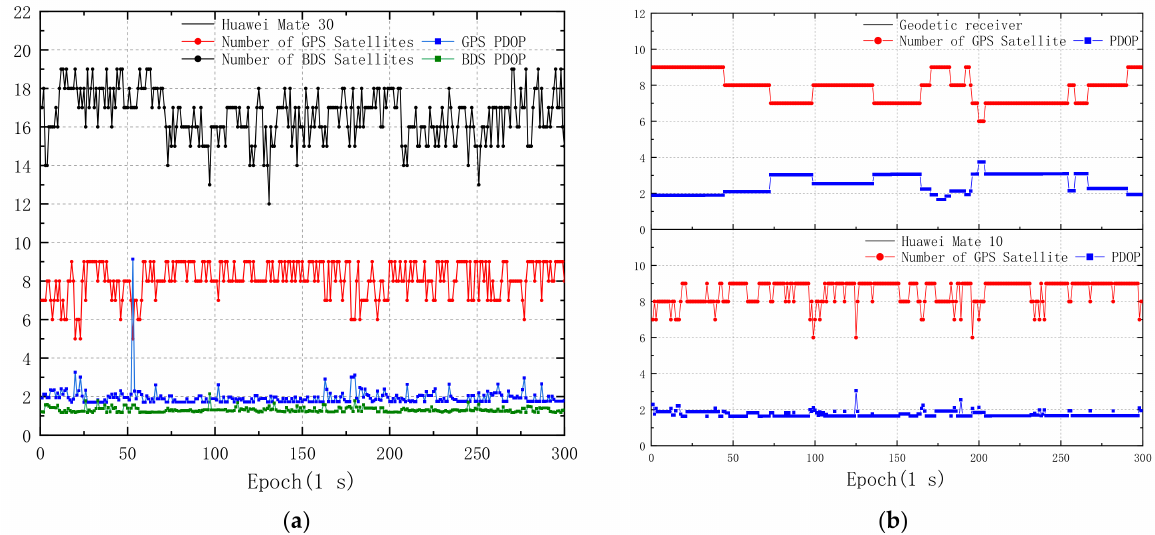
Figure 3. Number of GNSS satellites and PDOP values on the playground in area 1. ( a ) GPS and BDS measurements observed by Mate 30; ( b ) GPS measurements observed by the geodetic receiver and Mate